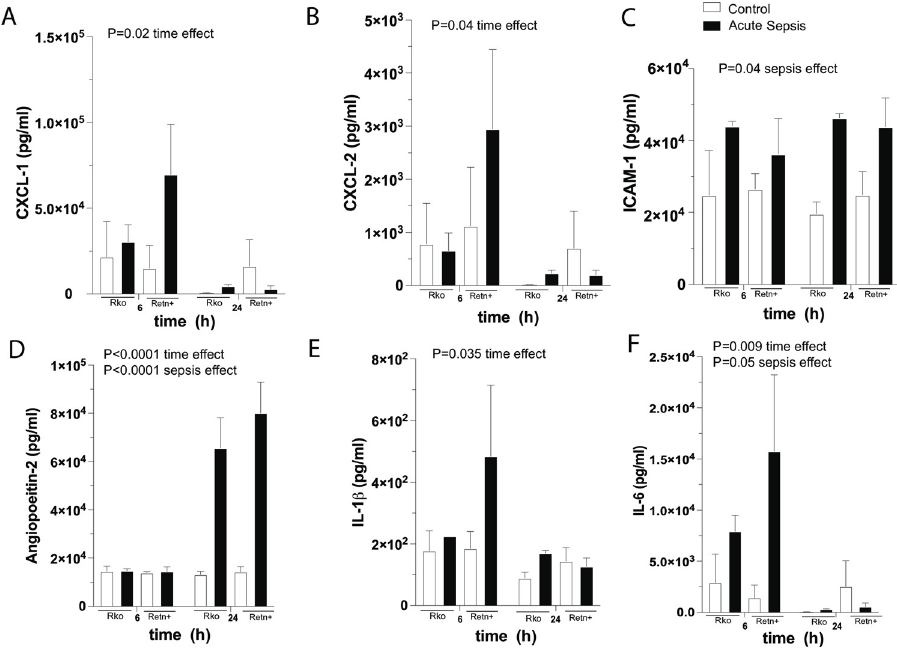
Fig 4. Serum concentrations of human cytokines in hRetn-/- mice (Rko) and mice expressing human resistin (Retn+). Concentrations were measured at 6 h and 24 h post-CLP. n = 4 for Retn+ at 6 h and 24 h, n = 2 for Rko at 6 h and n = 4 for Rko at 24 h. P values for statistically significant relationships on ordinary 3-way ANOVA (time versus sepsis effect versus genotype) are shown.